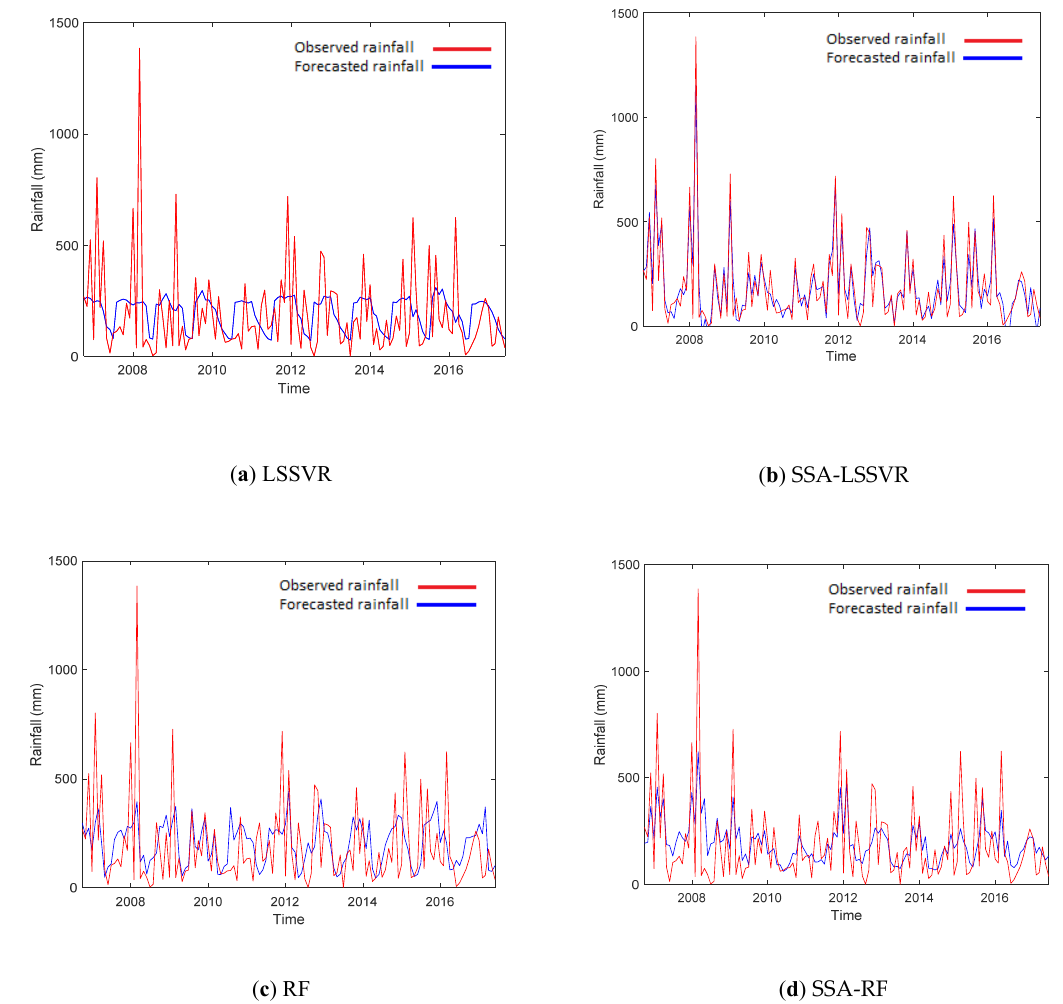
Figure 3. Time-series graphs comparing the observed and forecasted rainfalls by the ( a ) LS-SVR, ( b ) SSA-LSSVR, ( c ) RF, and ( d ) SSA-RF models during the validation period for Deji Reservoir watershed 1-month lead time.